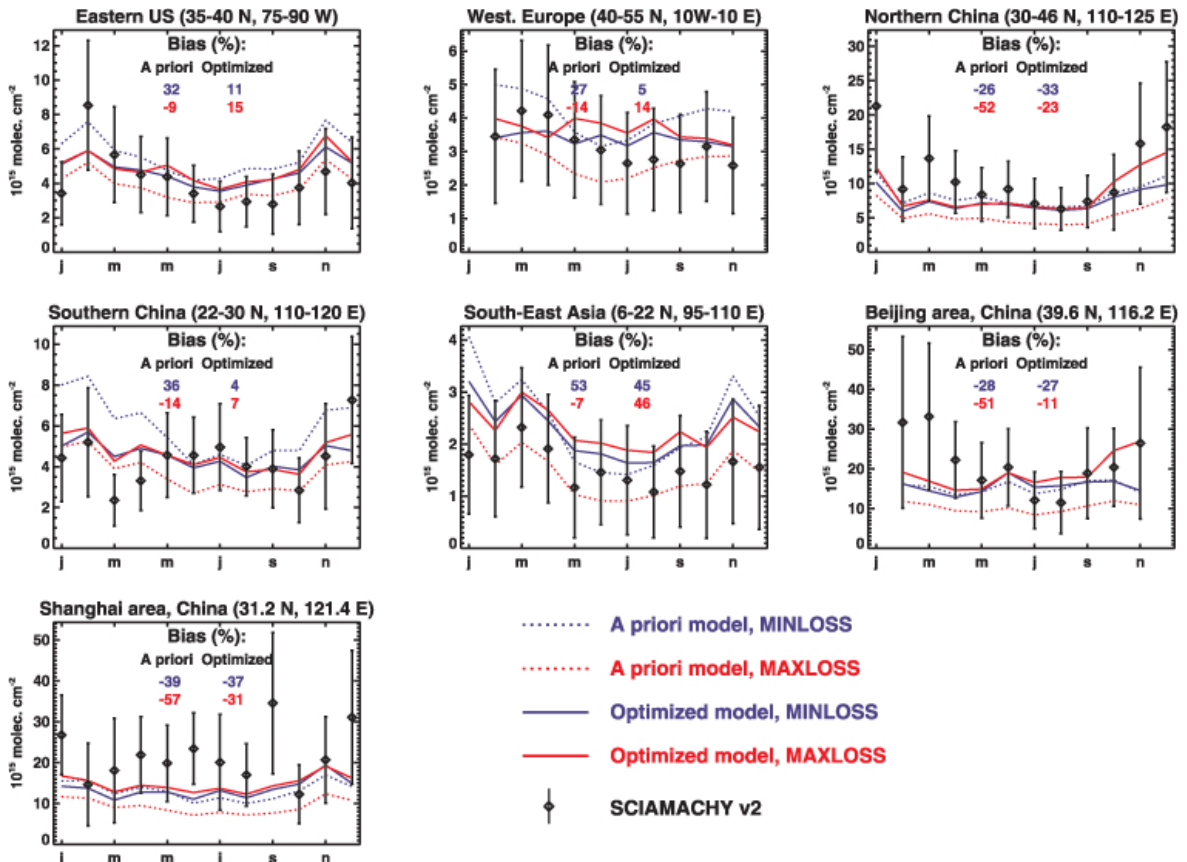
Fig. 10. Same as Fig. 9 but using SCIAMACHYv2 NO 2 retrievals and modelled columns calculated at the SCIAMACHY overpass time (10:00LT). The NO 2 column errors are estimated using the same algorithm as for DOMINO v2.